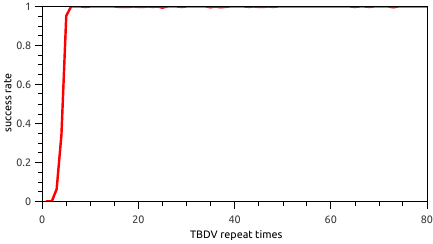
Figure 5: The success rate of executing “111,000” with different repeat times N